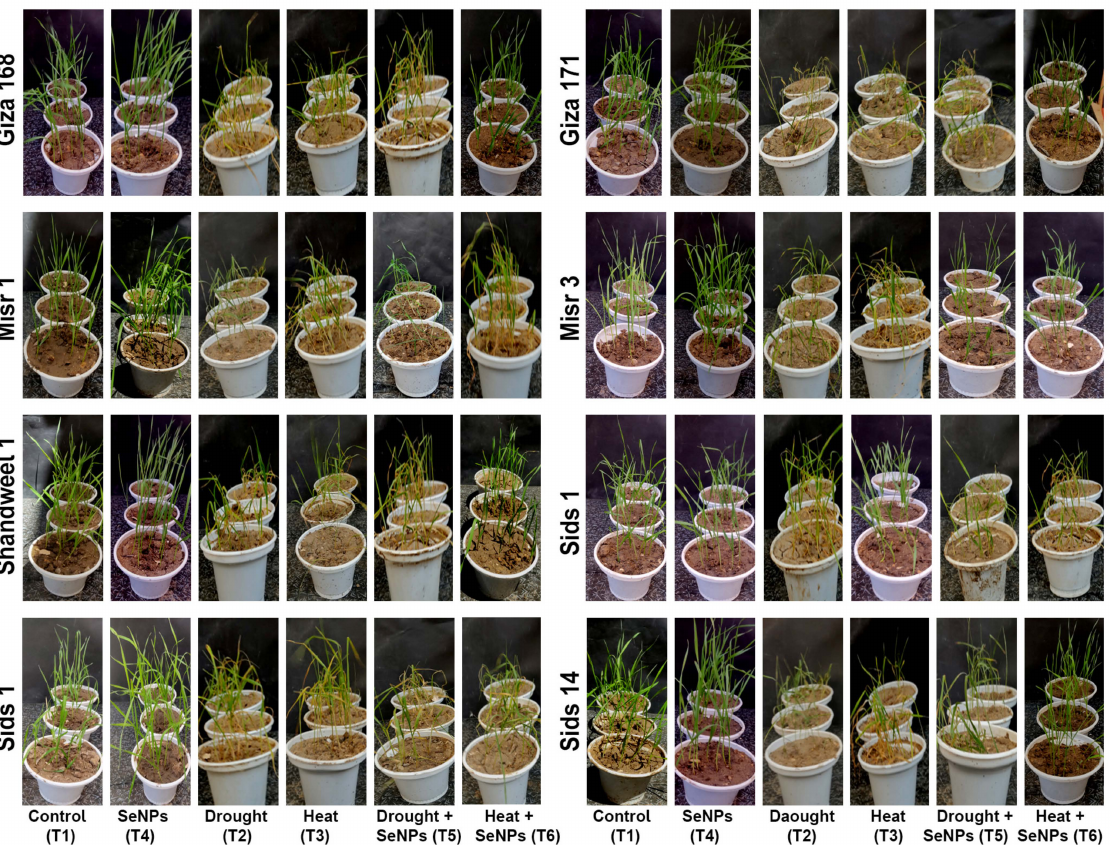
Figure 1. Morphological description of seedlings of eight wheat genotypes seedlings at 31 DAS grown under different growth conditions. Treatments: T1, control (regular irrigation, 100% Field Capacity (FC)) at (day/night) temperature of 23/17 ± 3 ◦ C; T2, drought stress (60% FC); T3, heat stress (38 ◦ C); T4, 10 mg · L − 1 of SeNPs; T5, drought stress (60% FC) + 10 mg · L − 1 of SeNPs; and T6, heat stress (38 ◦ C) + 10 mg · L − 1 of